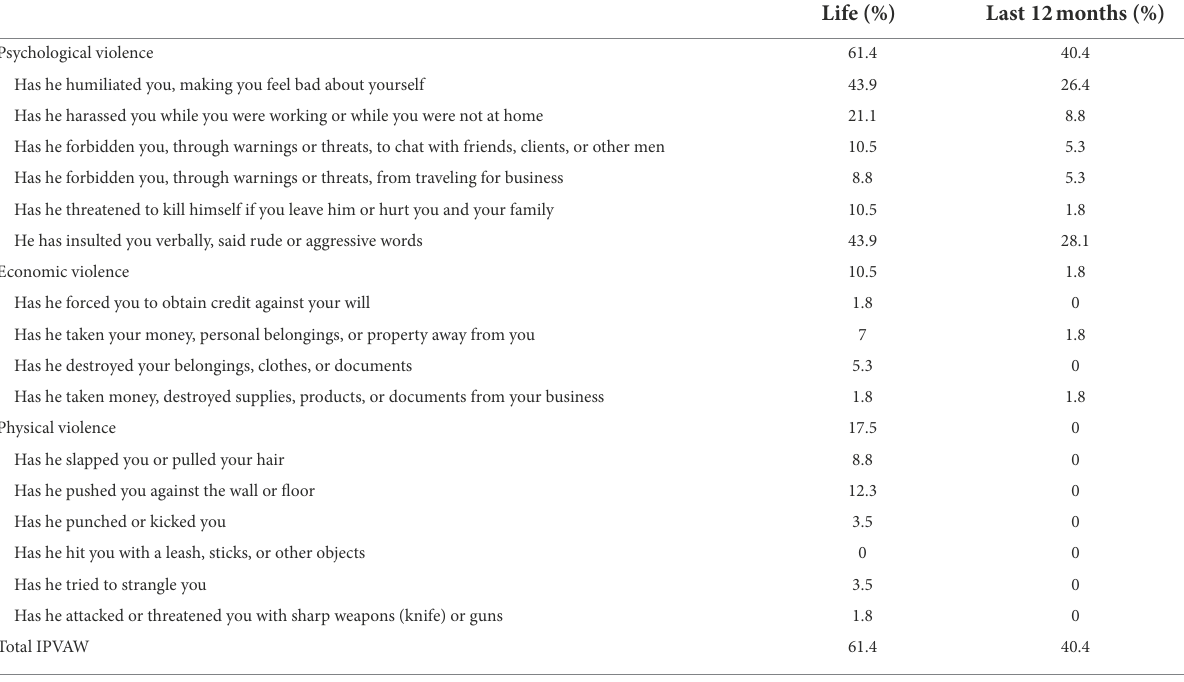
TABLE 4 Prevalence of problems performing export capabilities.